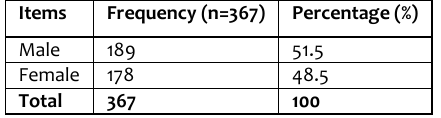
Table 2: Distribution of Respondents Based on Gender